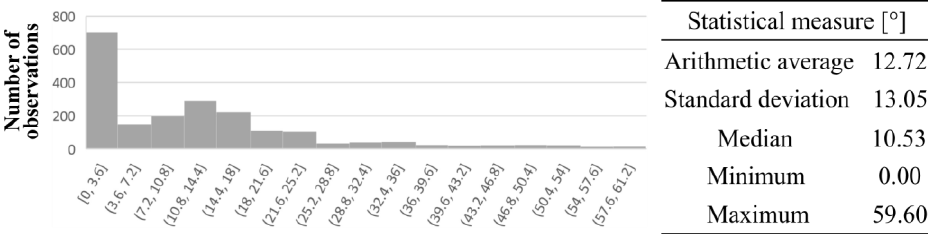
Figure 12. A histogram of error distribution course determination by the satellite compass with the sample statistical parameters in control analysis.